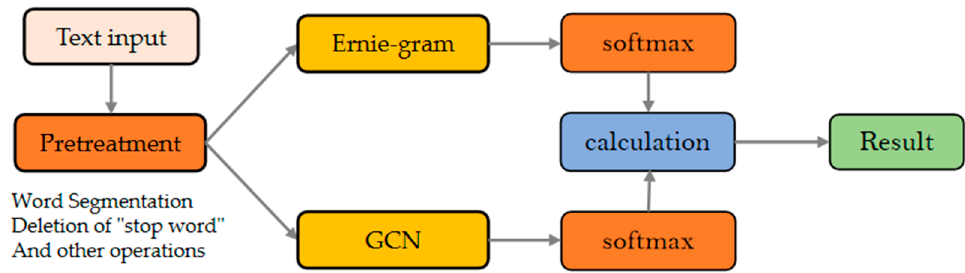
Figure 5. Structure diagram of EGC.